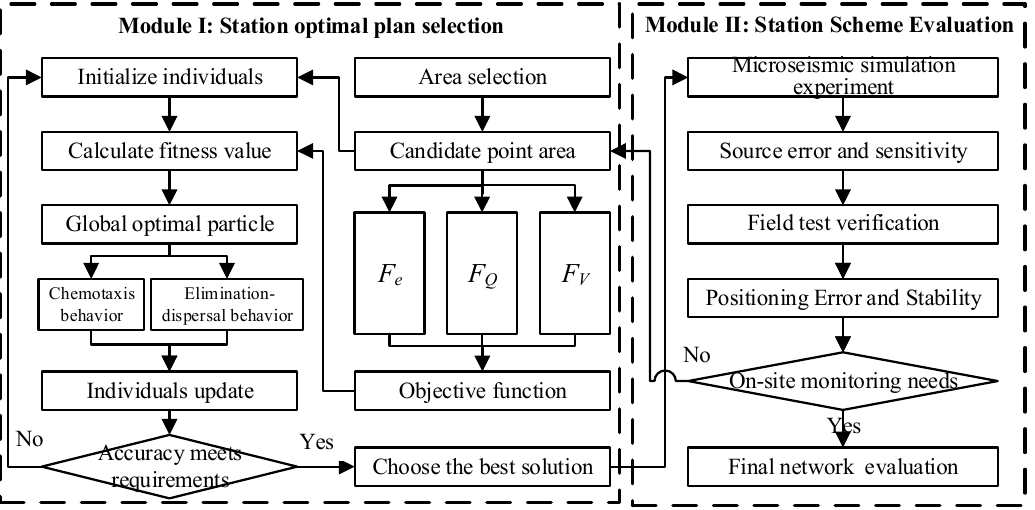
Figure 1. Flow chart of the microseismic network layout optimization.